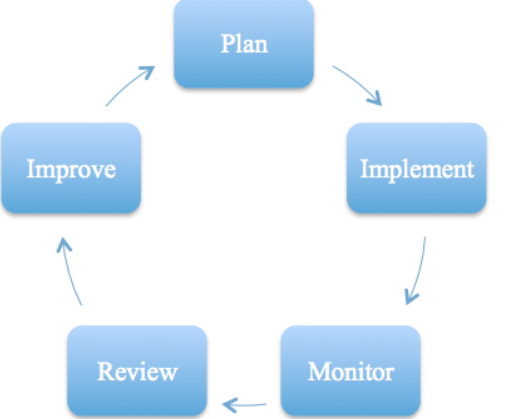
Figure 3. Agile Development approach using the PIMRI Cycle in the RADB project development